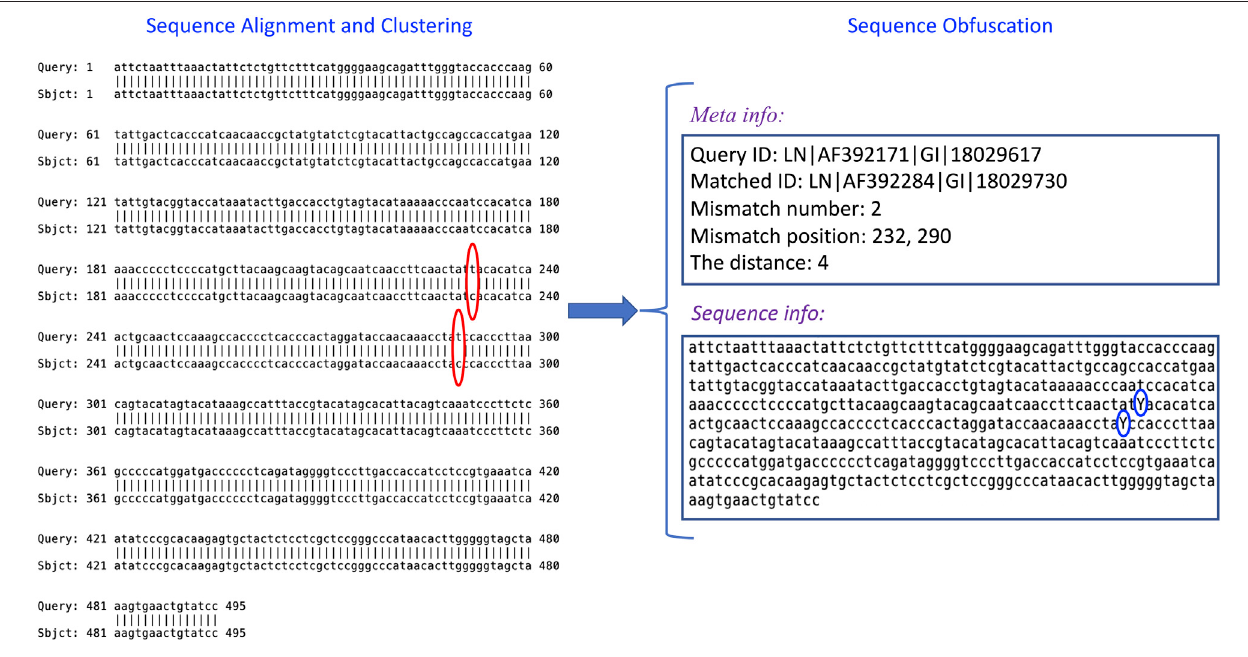
FIGURE 5 | An example of how IterMegaBLAST works. IterMegaBLAST consists of two major steps: sequence alignment and clustering, and sequence obfuscation. Given a query sequence, e.g., LN | AF392171 | GI | 18029617, IterMegaBLAST fi rst uses MegaBLAST to fi nd its top homolog, e.g., LN | AF392284 | GI | 18029730,whichformacluster.Then,IterMegaBLASTusesthesequenceobfuscationmethodintroducedin Section2.4 togeneratethegeneralized sequence (see the “ Sequence info ” box on the right panel) for this cluster. The distance is calculated and the related meta information is produced (see the “ Meta info ” box on the right panel). The red circles indicate the mismatched nucleotides between the query sequence and the homolog, and the blue circles represent the generalized nucleotides for the mismatches